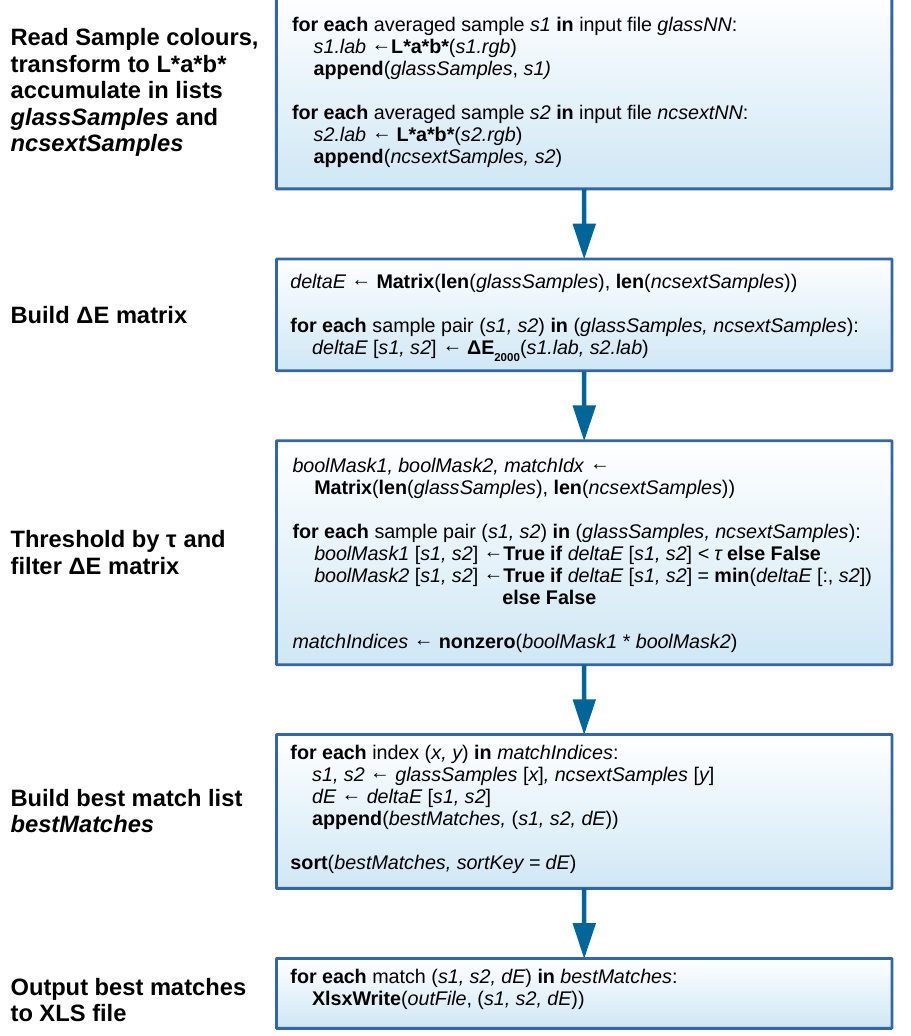
Figure 6. Flowchart of colour matching script based on ∆ E . The major tasks (input, ∆ E matrix generation, matrix filtering, best match extraction, and result output) are elaborated in pseudocode. Note that the matrix deltaE is indexed via the column and row corresponding to printed glass sample s 1 and NCS exterior sample s 2, respectively. The slicing operation deltaE [ :, s 2 ] selects all columns for the row corresponding to NCS exterior sample s 2. Filtering is accomplished by logically conjuncting the boolean matrices boolMask 1 and boolMask 2 through multiplication. The function nonzero () returns the indices of all matrix entries which evaluate to True